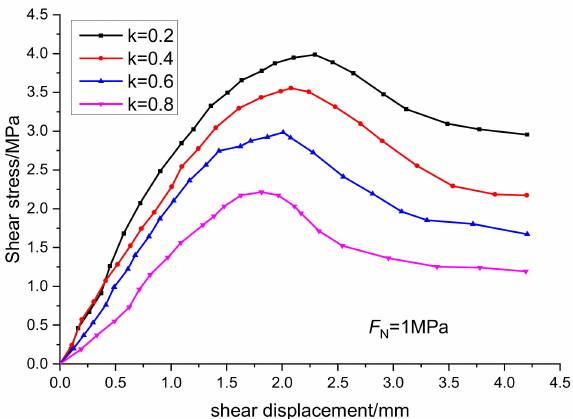
Figure 10. Relationship curves between shear stress and shear displacement at di ff erent continuity rates.